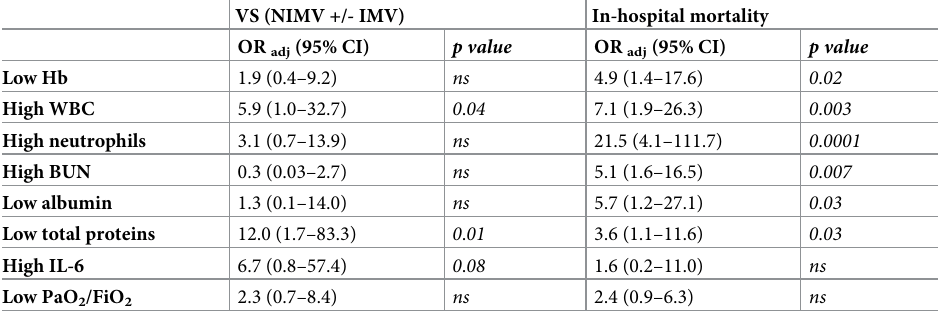
Abbreviations: BUN, blood urea nitrogen ; Hb, hemoglobin ; IL-6, interleukin-6 ; IMV, invasive mechanical ventilation ; NIMV, non-invasive mechanical ventilation ; ns, not significant ; VS, ventilation support ; WBC, white blood cell . Low Hb if < 12 g/dL; High WBC > 10.8 x10 9 /L; High neutrophils > 7.2 x10 9 /L; High BUN > 55 mg/dL; Low